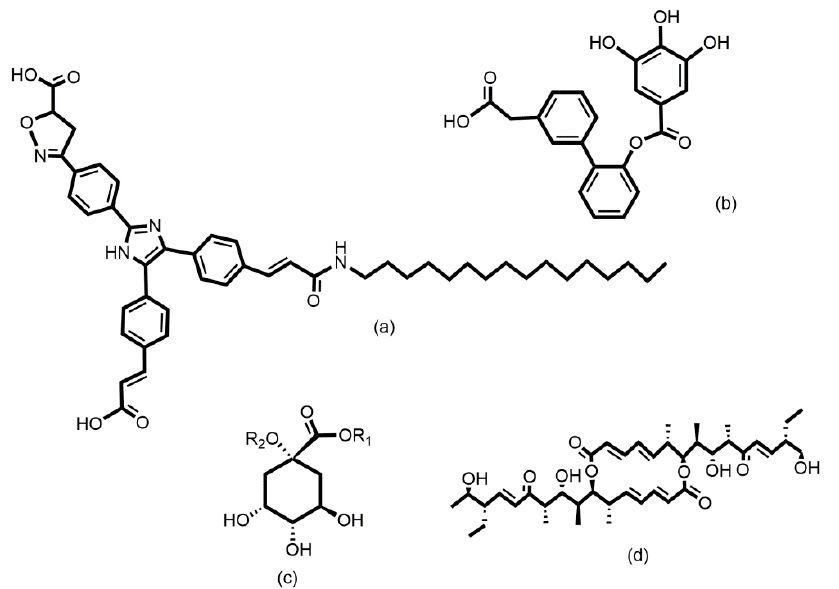
Figure 14. Schematic representation of selectin non-carbohydrate inhibitors: ( a ) imidazole-based derivative [371] ( IC 50 = 290 nM against P-selectin), ( b ) gallic acid analog [372] ( IC 50 = 870 nM against P-selectin), ( c ) quinic acid derivative [373], and ( d ) efomycin M [374].